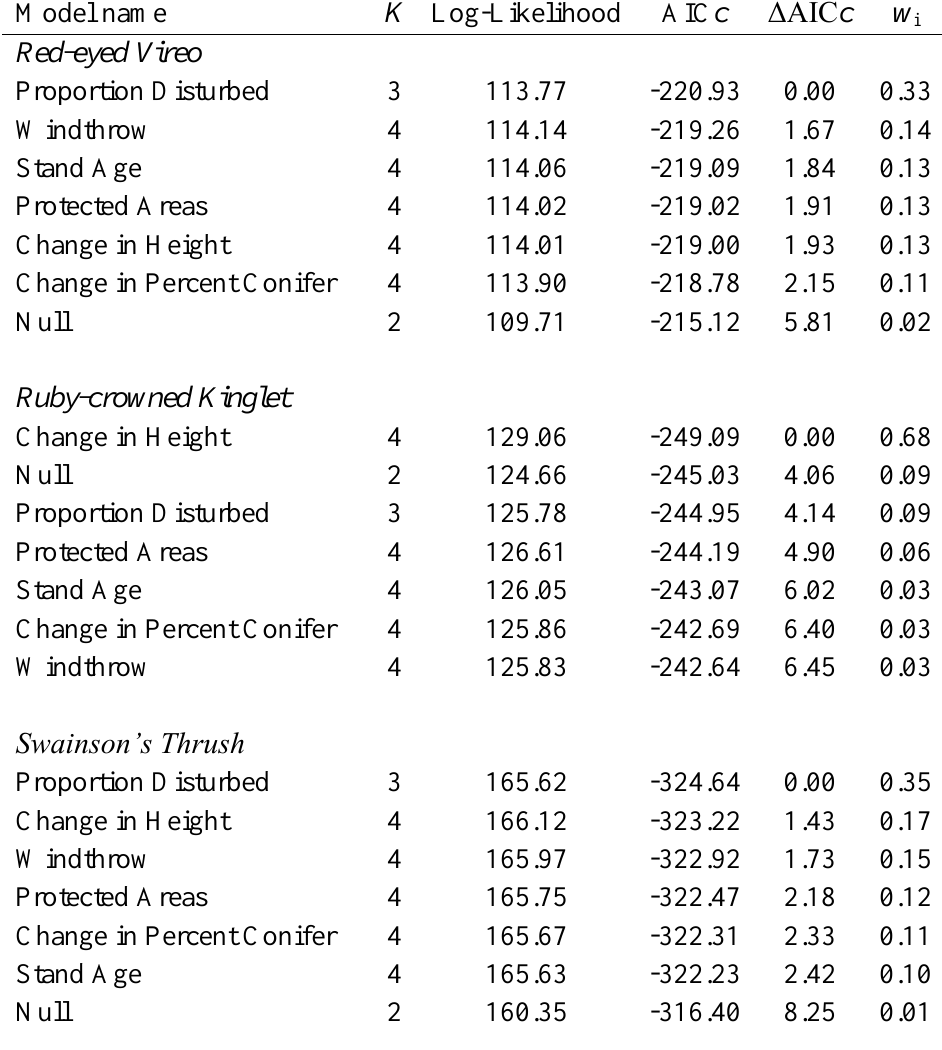
Table A1.1 Information theoretic based model selection for models examining variation in stand- level trends (between circa 1994 and 2014) in abundance for ten species of passerine in aspen dominated mixedwood forests in central Saskatchewan. K denotes the number of estimated parameters in the model, AIC c denotes Akaike’s Information Criterion with second-order bias correction, ΔAIC c is the difference in AIC c between the given model and the model with the lowest AIC c value, and w refers to the AIC c i